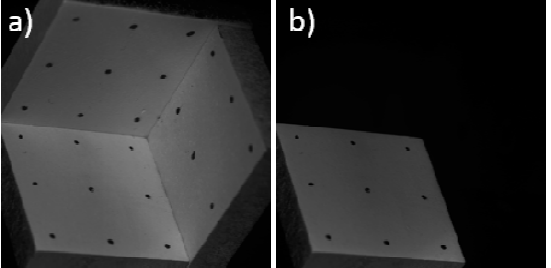
Fig. 3 Raw images of the test model in single-surface and 3- surfaces